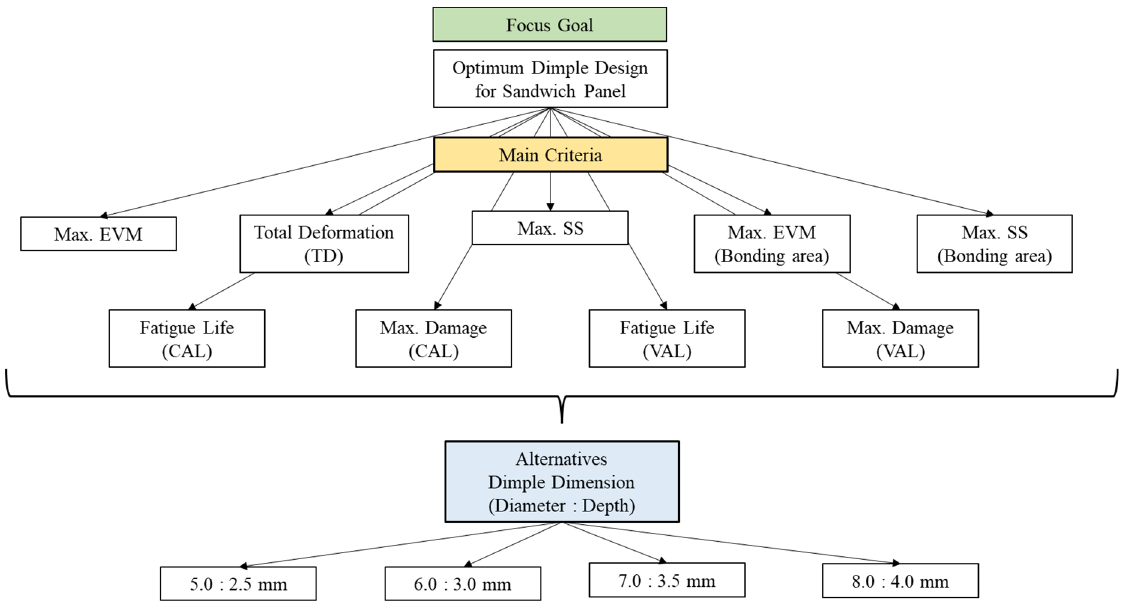
Figure 6. The developed hierarchical tree determined from finite element analysis (FEA).